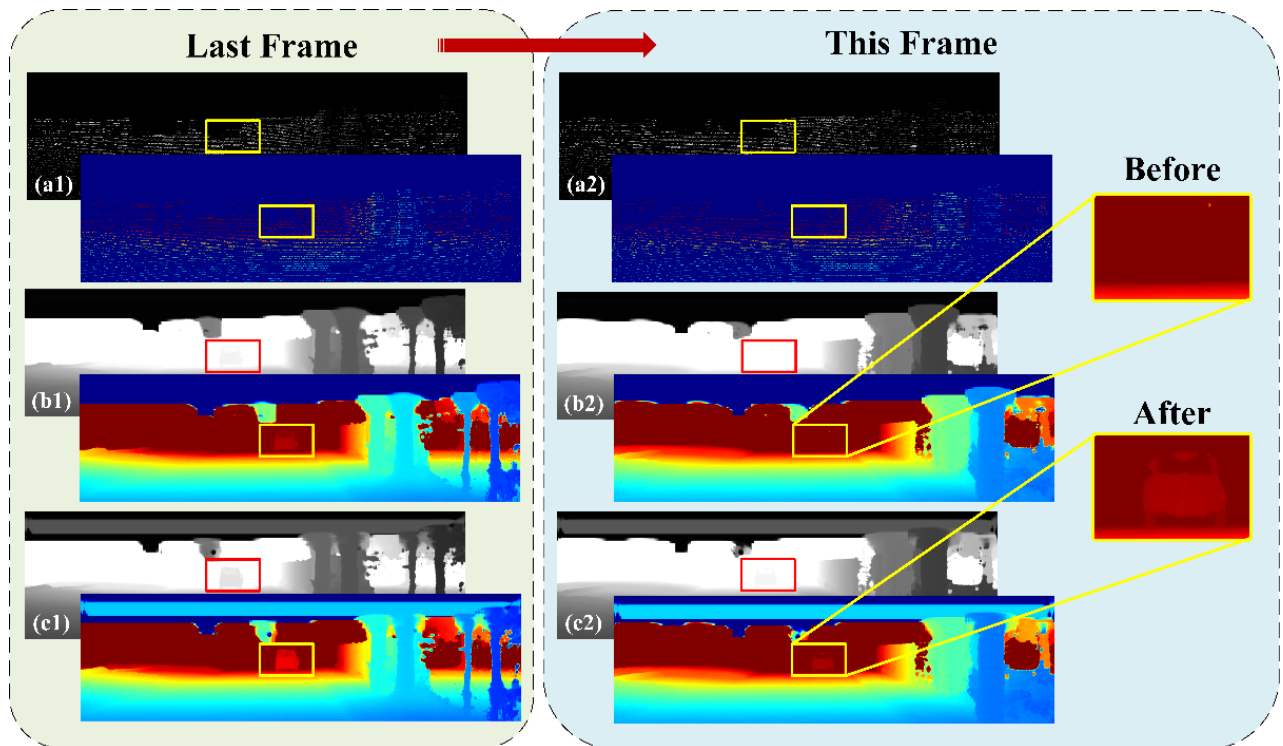
Figure 8. The effects of the dense progressive fusion module. The image from the previous frame is shown in the left box, and the image from the contrast frame is shown in the right box. ( a ) is the ground truth. ( b ) is the output before joining the module. ( c ) is the output after joining the module. Their lower right corner is their false-color image.